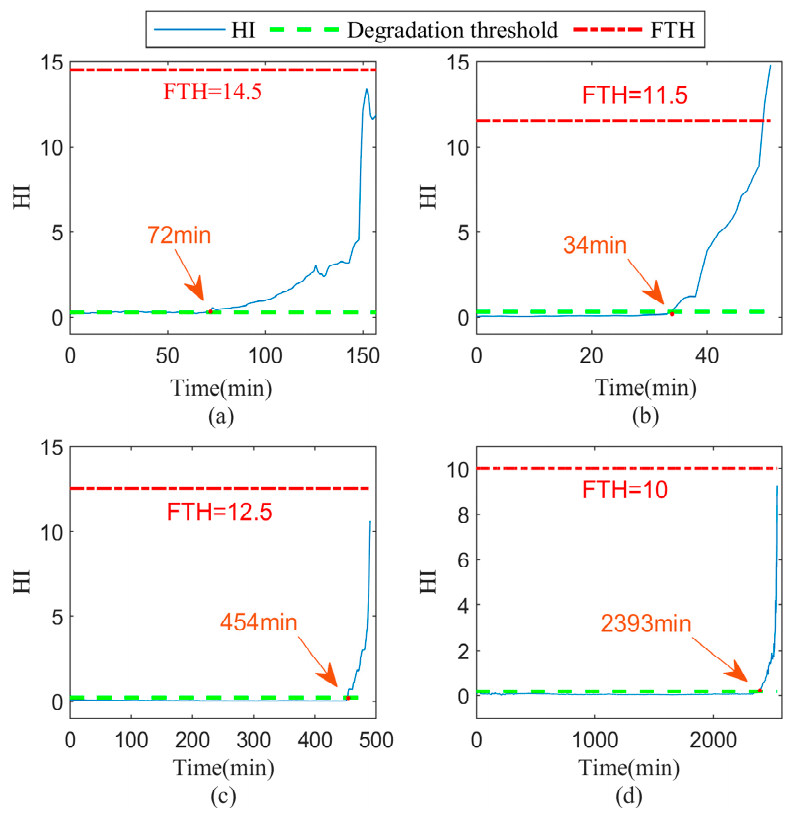
Figure 5. HIs for TTF prognostics of ( a ) bearing 1_3, ( b ) bearing 1_5, ( c ) bearing 2_1, and ( d ) bearing 3_1. ing